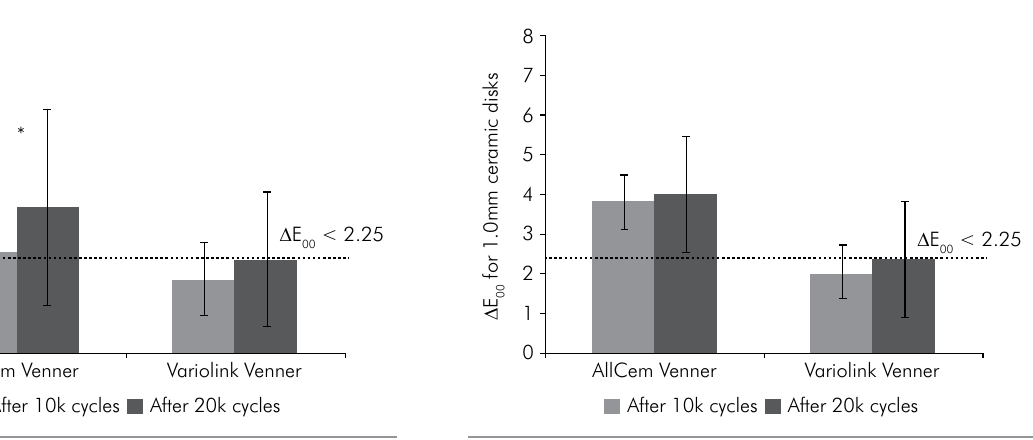
Figure 1. rE values for analysis of color stability of 0.5 mm- 00 thick bonded ceramic disks after 10,000 and 20,000 thermal cycles. rE values lower than 2.25 were considered clinically 00 imperceptible. * indicates significant differences after 10,000 and 20,000 thermal cycles in the same brand.